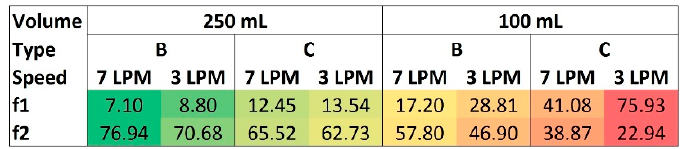
Figure 8. Difference (f1) and similarity (f2) factor analysis for comparison of compartment types B and C with the USP 2 dissolution test. Profiles were similar if f1 < 15 and f2 > 50.